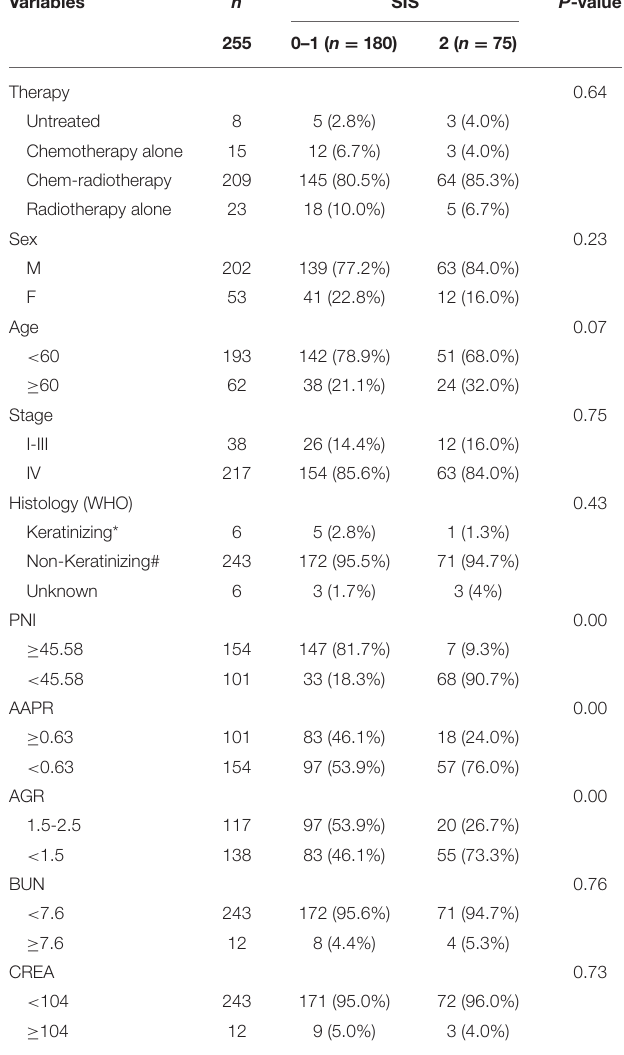
TABLE 2 | Clinical characteristics of patients with NPC. OS. The death risk in patients with low AGR was 11.75